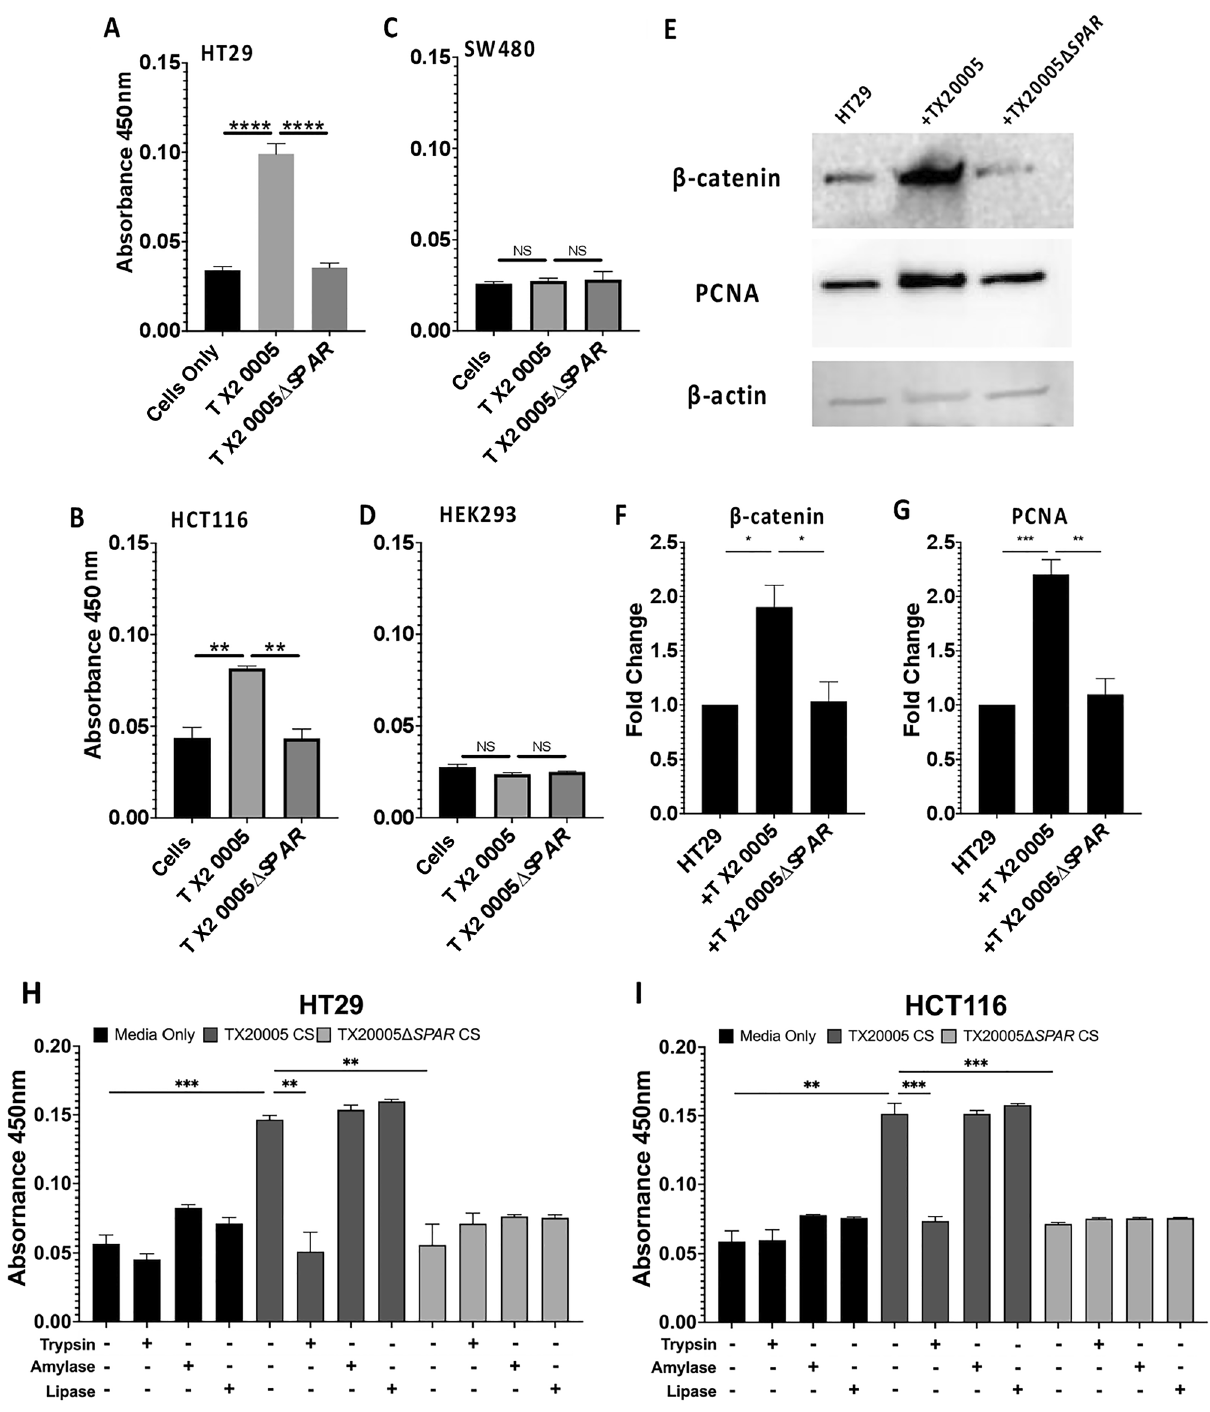
Figure 3. SPAR is essential for Sgg to stimulate CRC cell proliferation. A - D . Cell proliferation assay. HT29 ( A ), HCT116 ( B ), SW480 ( C ), and HEK293 ( D ) cells were incubated in the presence or absence of bacteria (MOI = 1) or CSs for 24 h, as described in the “Materials and Methods” section. Cell proliferation was measured using a CCK-8 kit. Cell-free wells containing only the culture media served as a blank control to which the absorbance values were normalized. E – G . Western blot. Cell lysates from HT29 cells co-cultured in the presence or absence of bacteria (MOI = 1) were analyzed by western blot, probed with antibodies against β-catenin, PCNA, and β-actin ( E ). Band intensity was quantified and normalized to β-actin. Fold change in β-catenin ( F ) and PCNA ( G ) were calculated against cells incubated in media only. Data was combined from three biological replicates. H and I . Cell proliferation in the presence of Sgg CSs. HT29 cells ( H ) or HCT116 cells ( I ) were cultured in the presence or absence of WT or mutant Sgg (MOI = 1) or CSs from WT or mutant Sgg for 24 h that were untreated with any enzyme, or pretreated with 50 mM trypsin, 50 mM α-amylase, or 50 mM lipase for 1 h at 37 °C. Cell proliferation was measured by using a CCK-8 kit. Results were combined from at least three biological replicates. Unpaired two-tailed t tests were used for the comparisons. * p < 0.05; ** p < 0.01; *** p < 0.001; **** p < 0.0001; ns, not significant. Significance in panels H and I indicates comparison to untreated cells. Results are combined from at least three independent experiments. The mean + /− SEM are